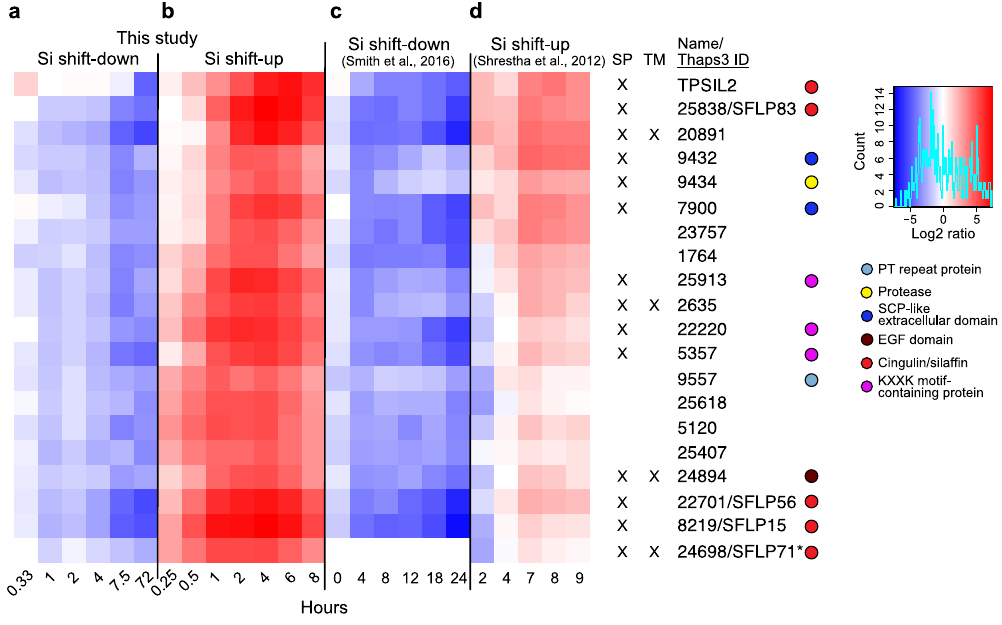
Figure 2. TpSIL2 is part of a cluster of a cluster enriched in Silaffin-like proteins. Heat map representing log2- transformed fold change in expression for the indicated time points of the ( a ) Si shift-down and ( b ) Si shift-up experiments, together with expression data from ( c ) Smith 36 and ( d ) Shrestha 35 . Numbers indicate JGI Thaps3 gene IDs. The colour key and histogram is shown to the right. Coloured circles indicate the presence of selected known domains. Tp24698/SFLP71 (marked with an asterisk) was not present in the Smith 36 dataset. SP, signal peptide; TM, transmembrane